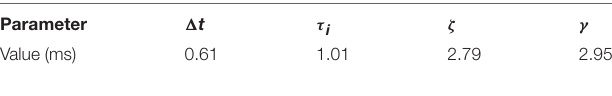
TABLE 2 | Optimal parameter values for the LFP